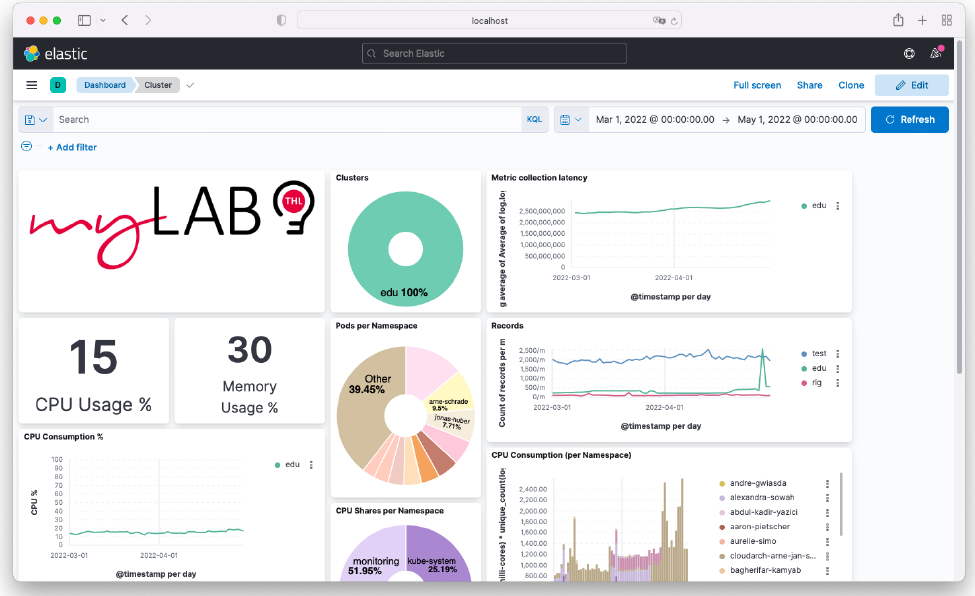
Figure 6. Use Case 3: The dashboard of the Kubernetes infrastructure under observation (myLab).